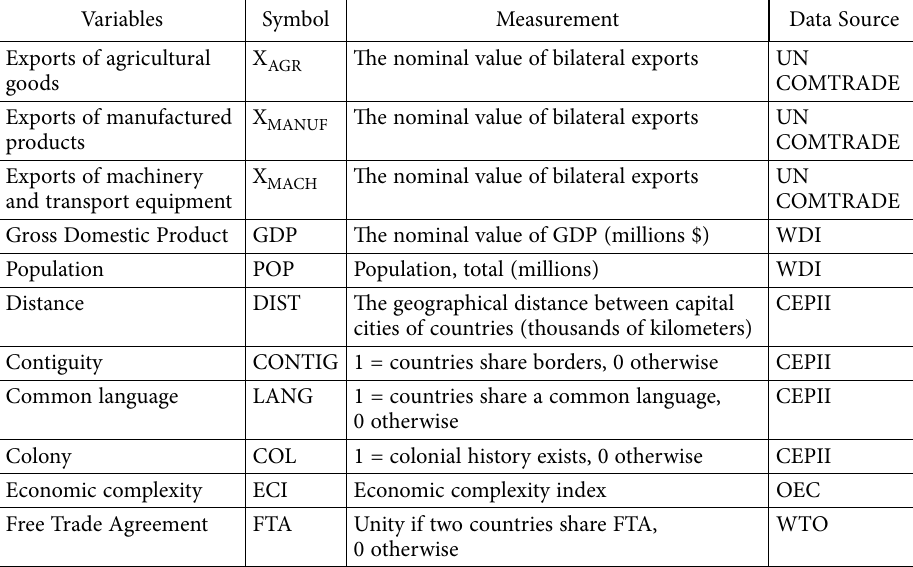
Table 1. Variables, measurement, and data